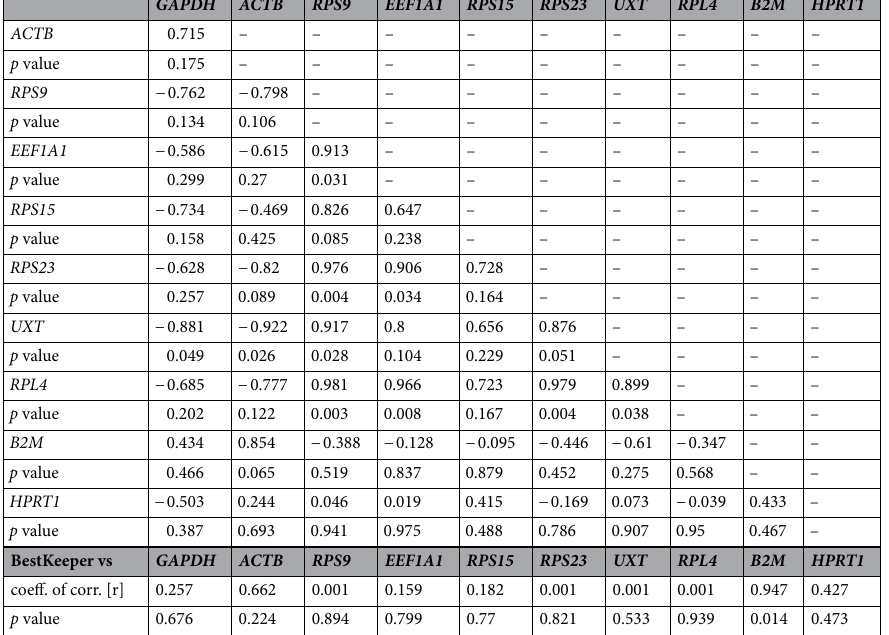
Table 15. Analysis of repeated pair-wise correlation amongst genes in ZAP with BestKeeper index.